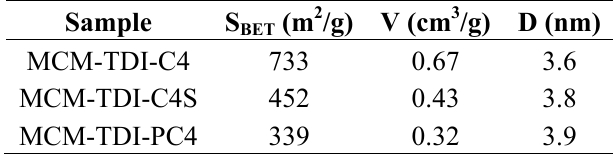
Table 1. Structural parameters of synthetic